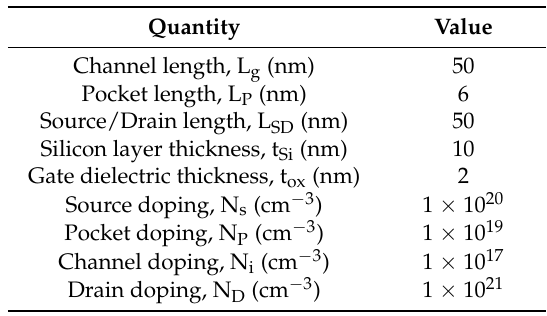
Table A1. Device parameters used in the calculation and simulation.